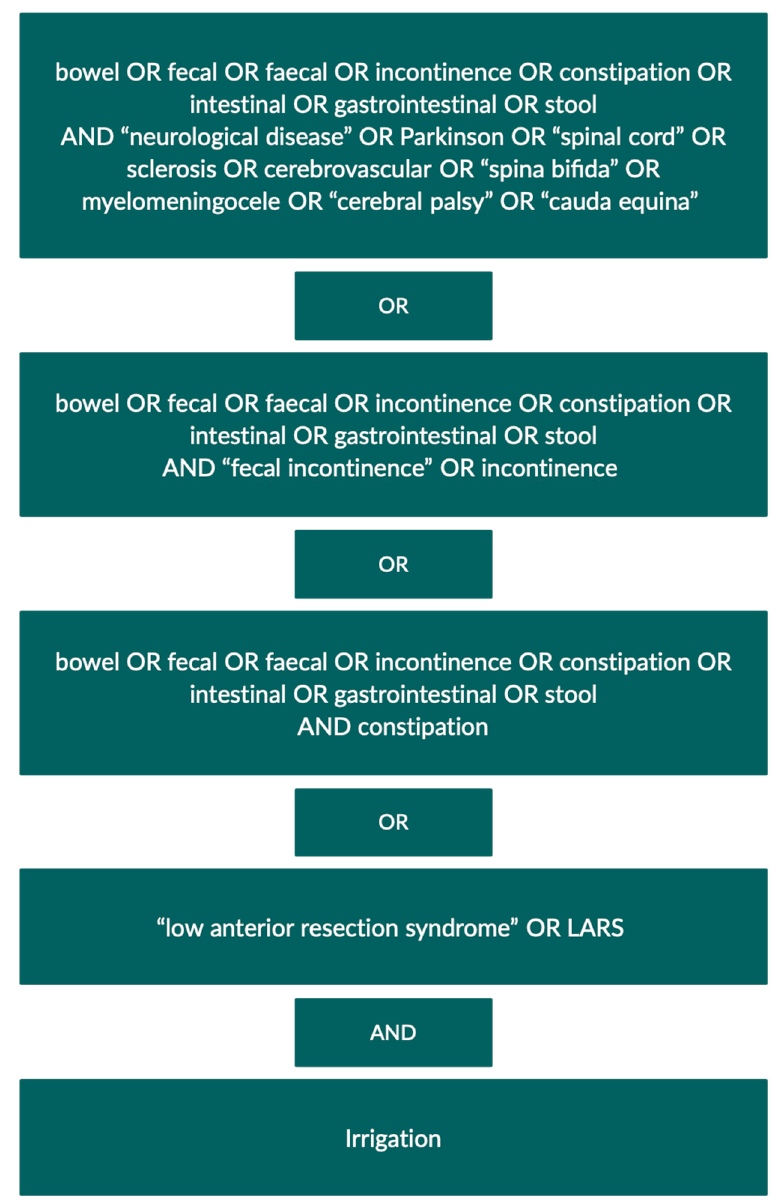
Figure 1. Search Figure 1. Search strategy.